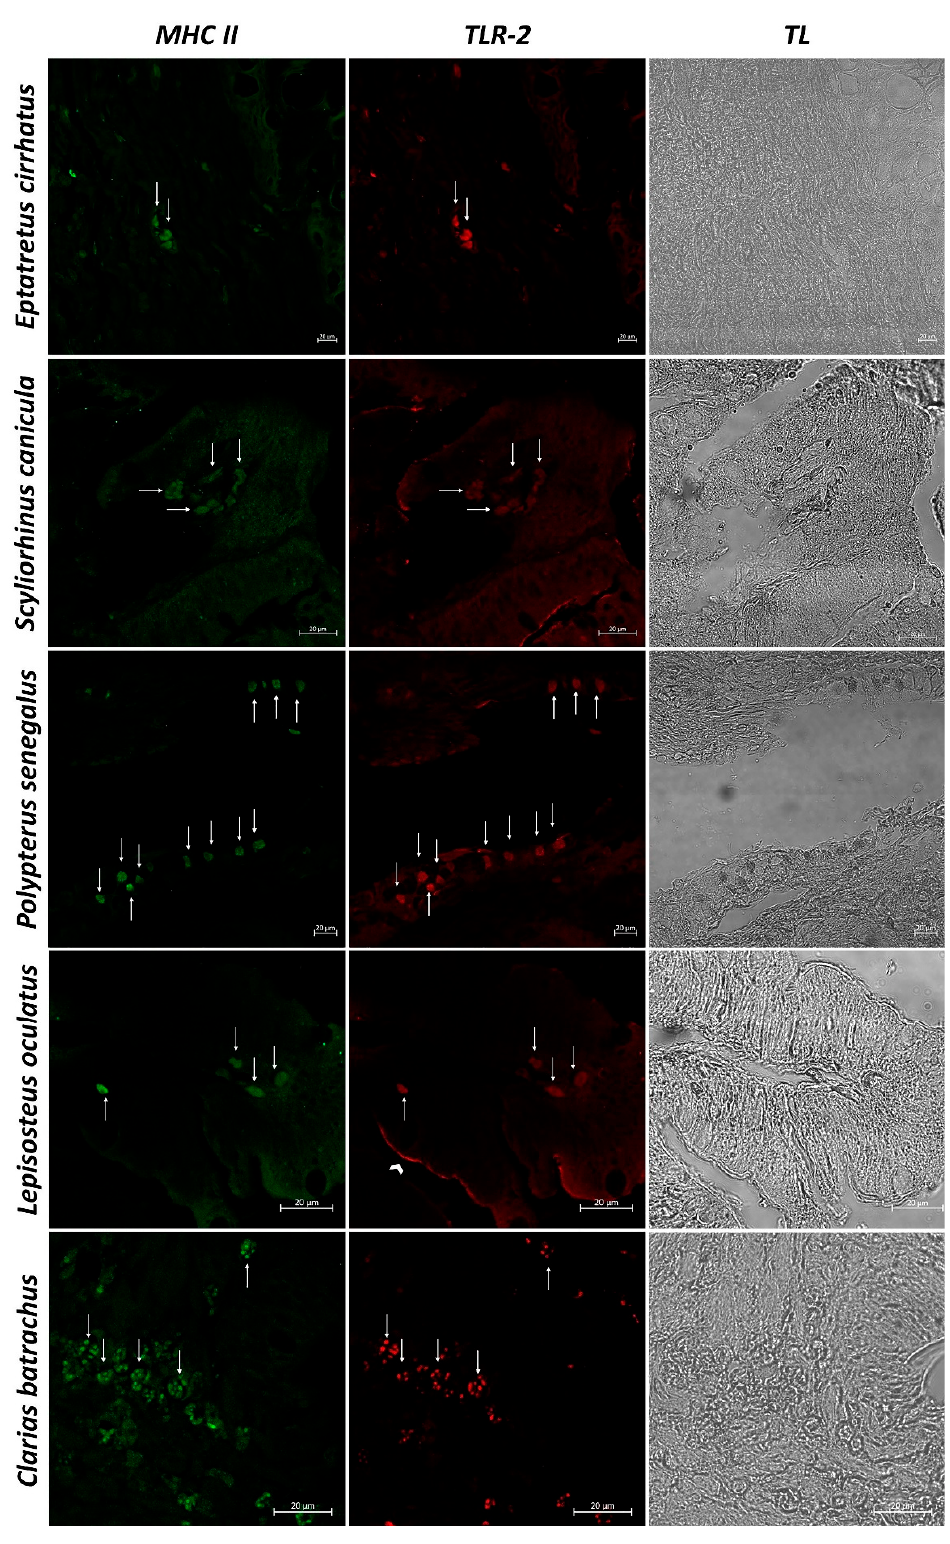
Figure 6. Immunofluorescence of MHC II and TLR-2, 40x, scale bar 20 µm. The immunopositivity to MHC II (green) and TLR-2 (red) is evident in the mucosa ( Polypterus senegalus, Lepisosteus oculatus, and Clarias batrachus ), lamina propria ( Scyliorhinus canicula ), and submucosa ( Eptatretus cirrhatus ) (arrows). Enterocytes (arrowhead) are positive for TLR-2 in the intestine of Lepisosteus. Transmitted Light (TL) is used to compare the organ